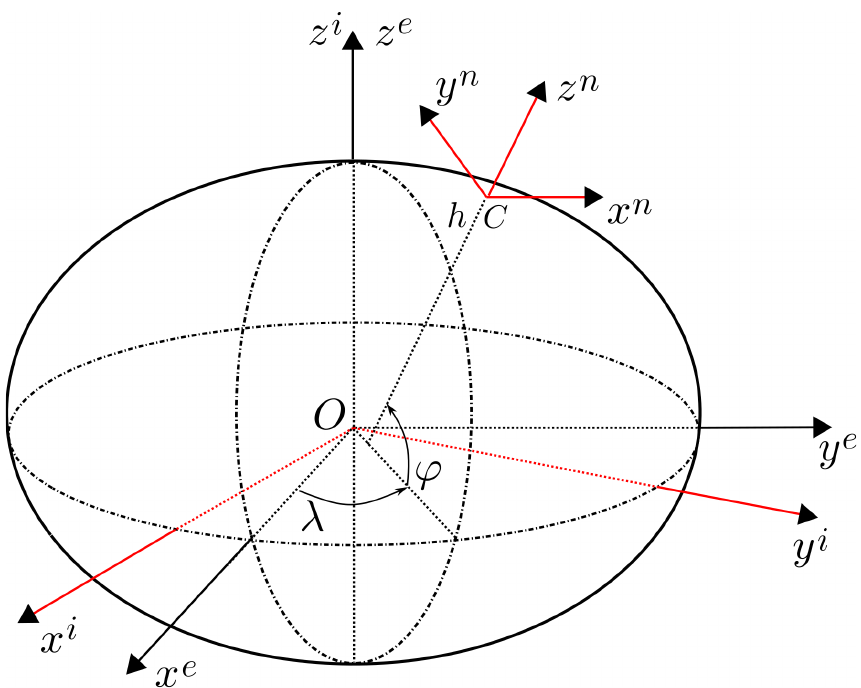
Figure A1. View of the inertial reference frame Ox i y i z i ( i -frame), the Earth fixed, reference frame ( Ox e y e z e ) ( e -frame) and the navigation reference frame ( Cx e y e z e ) ( n -frame). The point O corresponds to the centre of the Earth represented by an ellipsoid of revolution whose axis of revolution is the pole axis ( Oz i ) . The number triplet ( λ , ϕ , h ) denote respectively the longitude, the geographic latitude and the ellipsoidal height of the point C